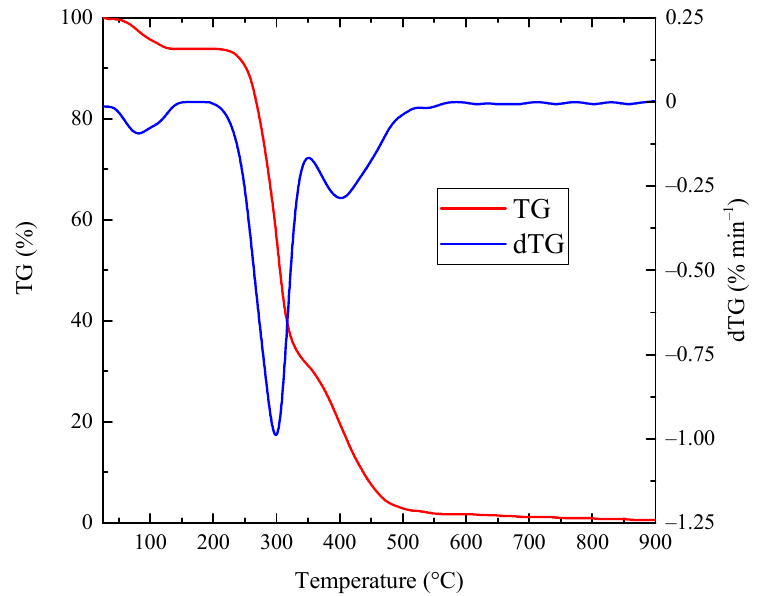
Figure 3. TG and dTG curves for the non-isothermal measurements with a heating rate of 5 °C min − 1 .